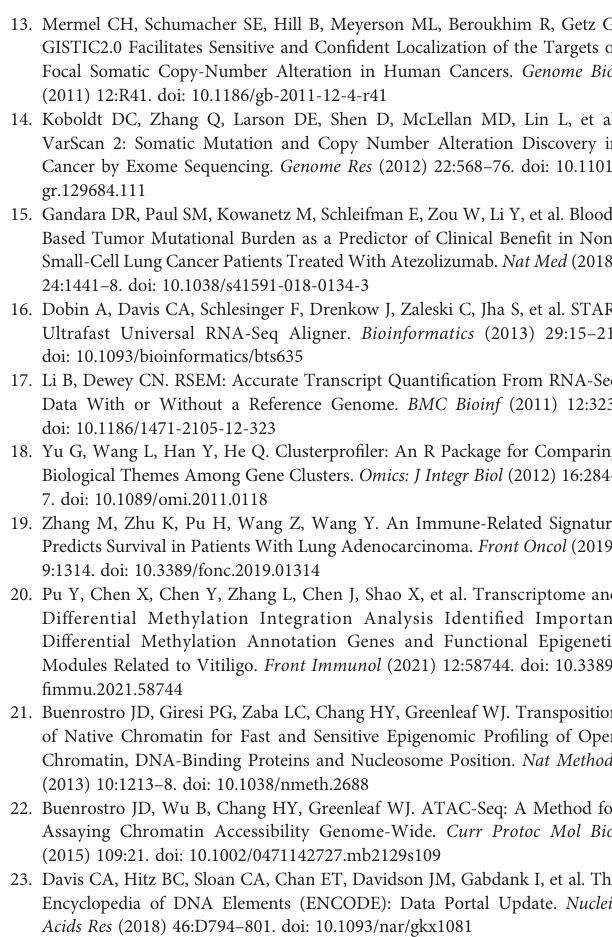
Supplementary Figure S1 | Representative HE staining images of ES and LS tissues (×4 magni fi cation; the lower right corner, ×40 magni fi cation). Supplementary Figure S2 | The fragment sizes in the sequencing library approximately ranging from 250 bp to 1000 bp. Supplementary Figure S3 | The number of somatic mutations in exon regions in ES and LS samples. Supplementary FigureS4 | Linechart showssigni fi cant copy numbergains (red) and losses (blue; FDR < 0.1) in ES and LS LUAD. Supplementary Figure S5 | Venn diagram of genes targeted by ampli fi ed or deleted CNV regions among ES and LS samples. Supplementary Figure S6 | Functional enrichment of genes targeted by ampli fi ed (left) or deleted (right) CNV regions among ES (top) and LS (bottom) samples. The enriched signaling pathways of ampli fi ed genes in ES (A) and LS samples (C) . The enriched signaling pathways of deleted genes in ES (B) and LS samples (D) . Supplementary Figure S7 | The complete mutation pro fi le of ES and LS LUAD. Supplementary Figure S8 | RNA-seq data analysis. (A) Volcano plot shows the differentially expressed genes (DEGs) between ES and LS groups. (B) Heatmap shows the hierarchical clustering of ES and LS samples based on the expression pro fi les of DEGs.